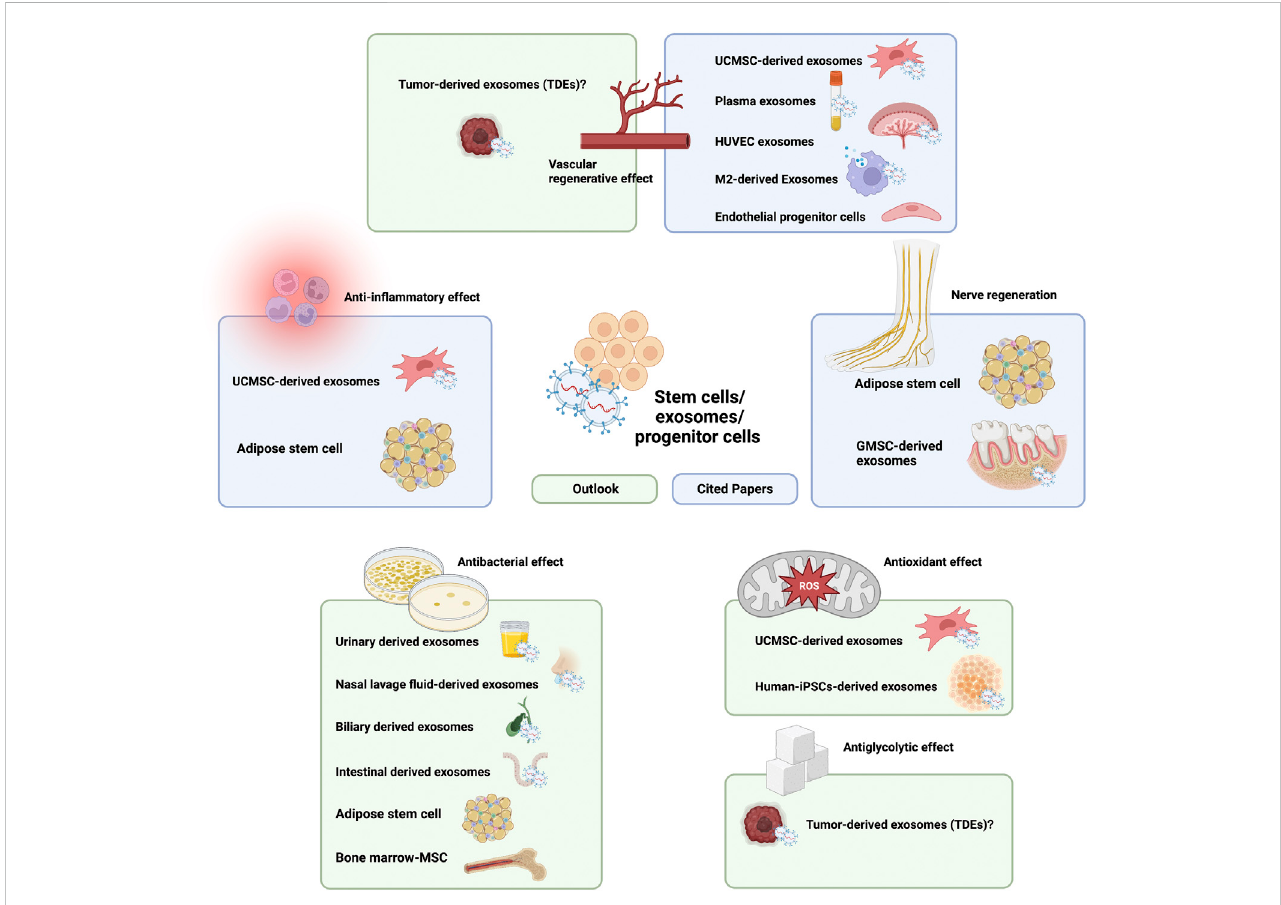
FIGURE 3 Current and future outlook of stem cell/exosome/progenitor cell components in hydrogel composites in the treatment of chronic diabetic